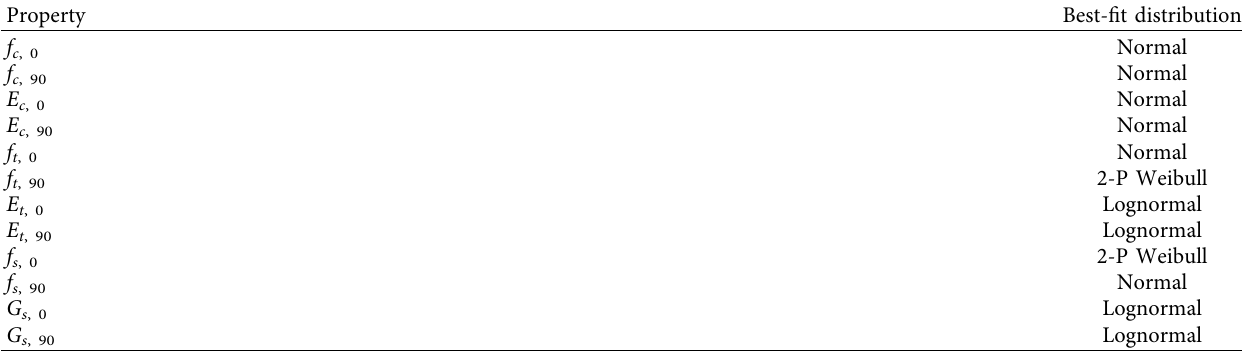
Table 6: The recommended best-fit distribution functions of the mechanical properties for EBC.